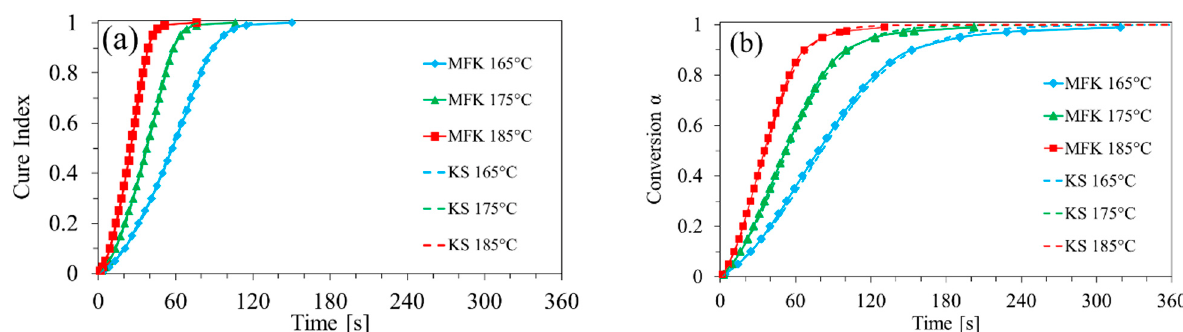
Figure 9. Cure simulations based on DEA ( a ) and DSC ( b ) with model free kinetics (MFK) and the Kamal-Sourour model fitting (KS) for a time period of six minutes corresponding to the cure time inside the mold tool.